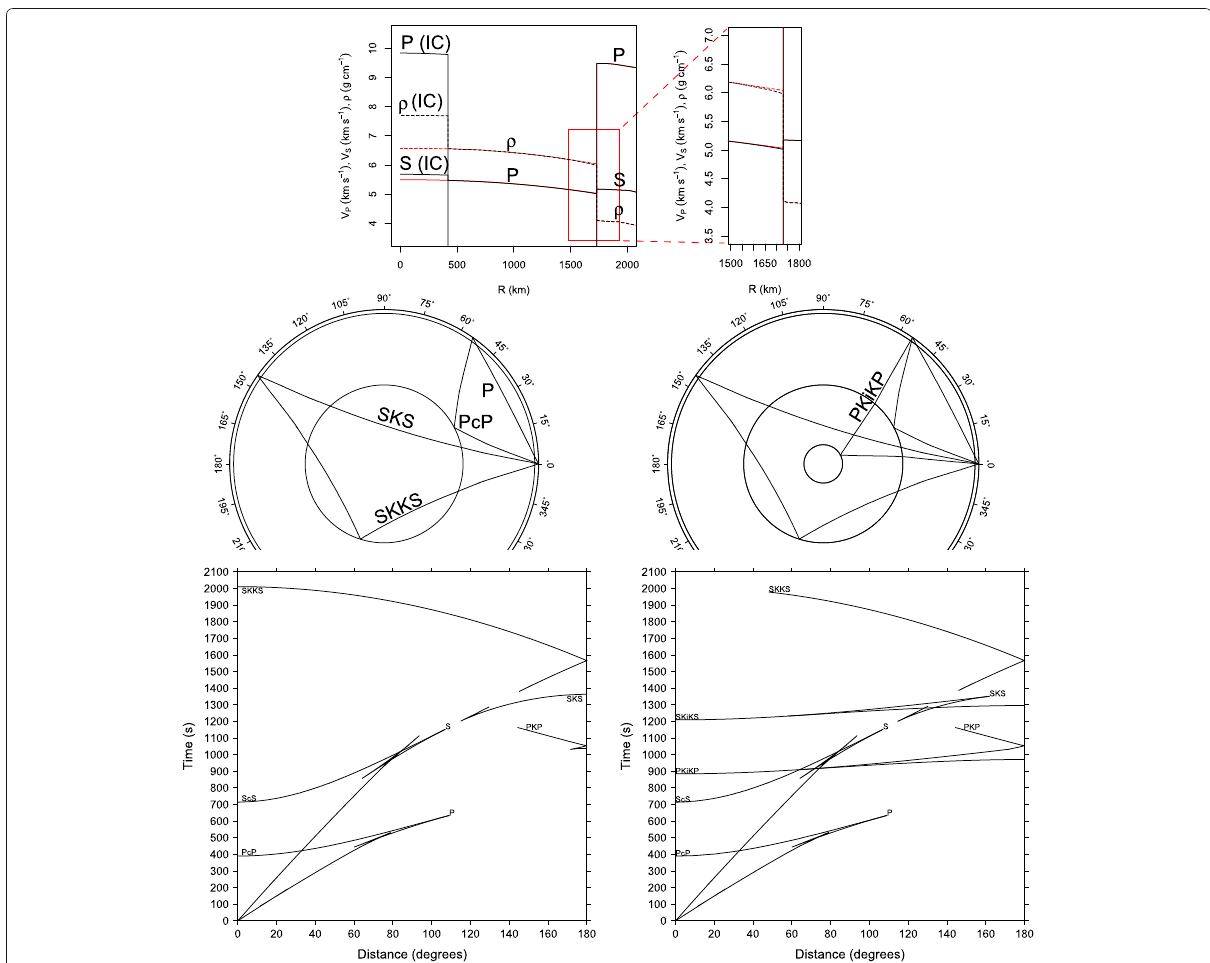
Fig. 10 Mars core structure when stratification and crystallization of an inner core occur simultaneously. Top panels show size of inner core (assumed Fe 3 S 2 ) and slight perturbation to density and P wave speed at the top of the outer core when stratification enriches sulfur in the core, lowering both density ρ and P wave speed in the outer core relative to unstratified state (red lines). The profiles of P, S and ρ in the inner core are labeled with (IC) for clarity; the unstratified P and ρ profiles (red) continue smoothly to Mars’ center. The inset (top right) of the boxed area near the CMB expands the density and P wavespeed profiles to emphasize their subtle structural changes. Bottom panels show ray paths and travel times for unstratified (left) and stratified (right) cases. The stratification itself is unobservable because P wavespeeds are already lower than S in the mantle, blocking minor-arc SKKS (Fig. 8, top). The only visible consequence of stratification is the presence of the inner core itself, indicated by the existence of PKiKP (and its extension to 180° as